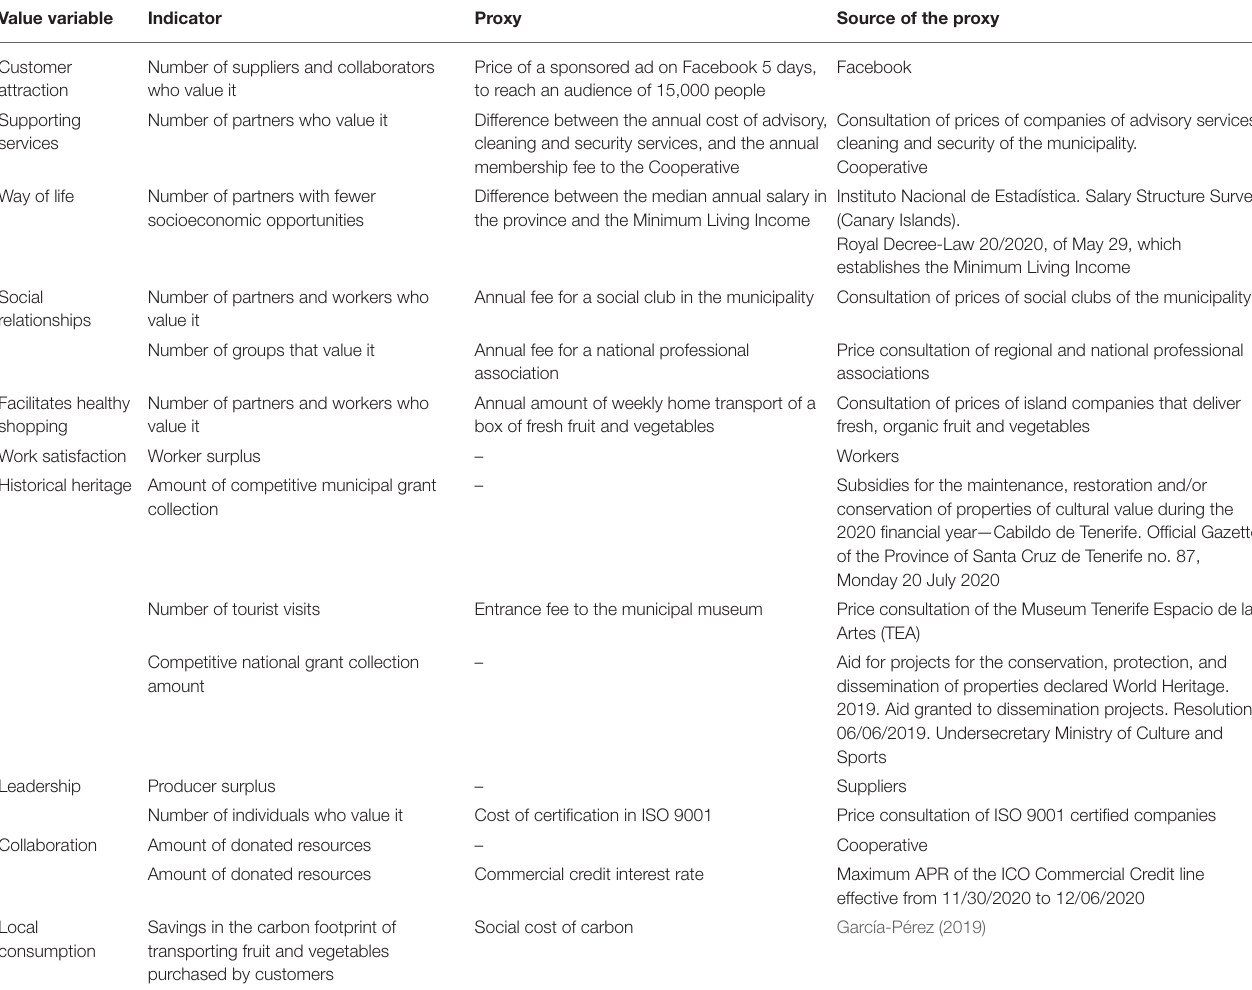
TABLE 4 | Indicators and proxies of value